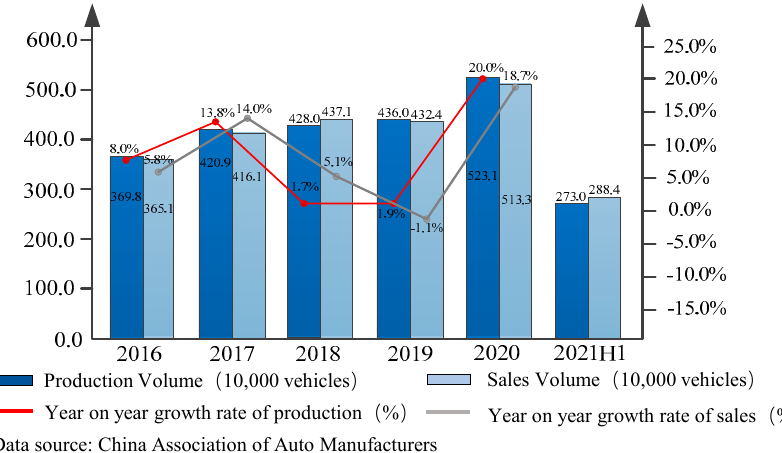
Figure 1. 2016–2021 (H1) development trend of China’s commercial vehicle market. The bottom working logic of the EBS is the process of converting the stroke of the brake pedal into an electric signal; combining the wheel speed and road surface information, the ECU calculates the required braking force under the current state, and then controls the actuator to generate the braking force on the wheel [3]. The system can combine relevant algorithms to improve control accuracy, shorten response delay time and ensure safety redundancy [4]. At present, the research on the pneumatic braking system of commercial vehicles is mainly based on the dynamic characteristics of the sys- tem based on ABS, ESC and other algorithms [5]. However, due to the sluggish pressure response and poor control accuracy in the braking process of commercial vehicles, the ideal braking effect cannot be achieved [6].